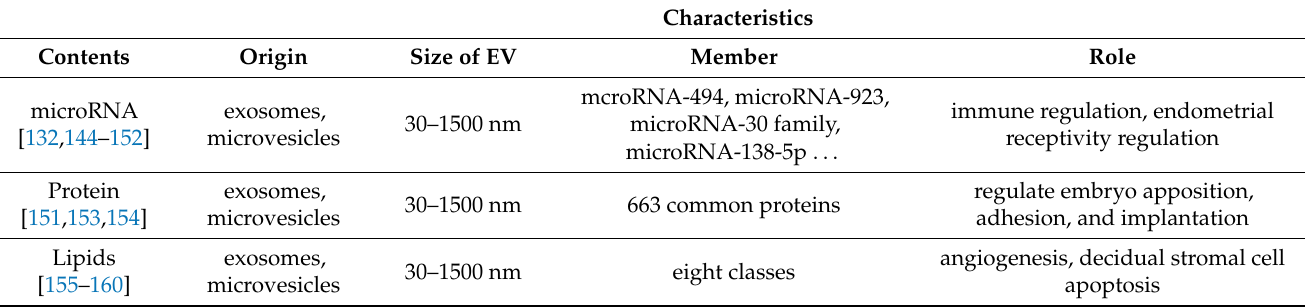
Table 2. Characteristics and cargo of extracellular vesicles. Characteristics